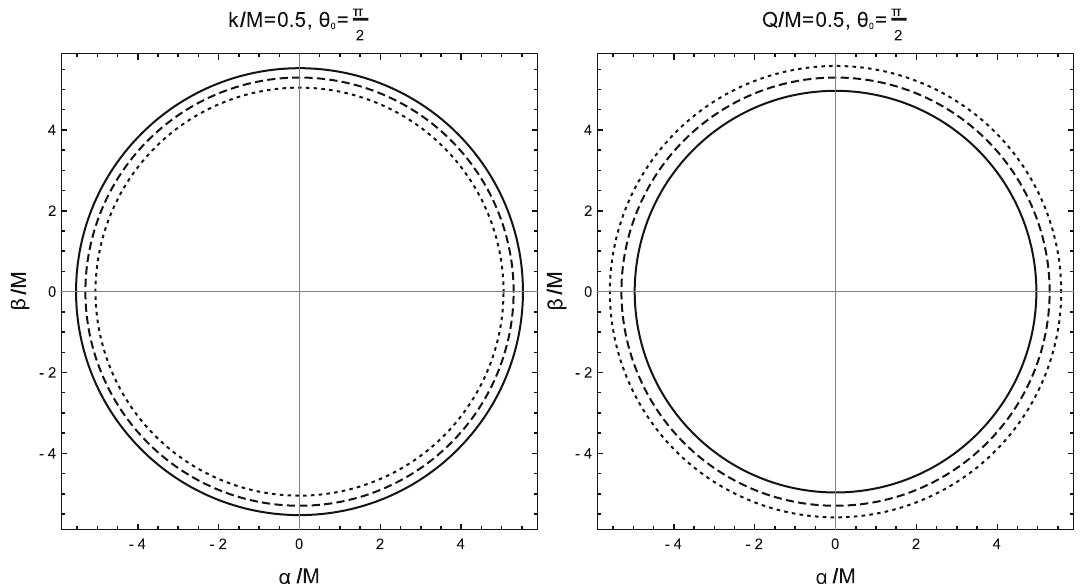
Fig. 6 A visualization of the silhouette for distinct charge and plasma parameters. In the left panel the solid, dashed and dotted plots correspond to Q / M = 0, 0.5 and 0.7, respectively. In the right panel the solid, dashed and dotted plots correspond to k / M = 0, 0.5 and 0.7, respectively